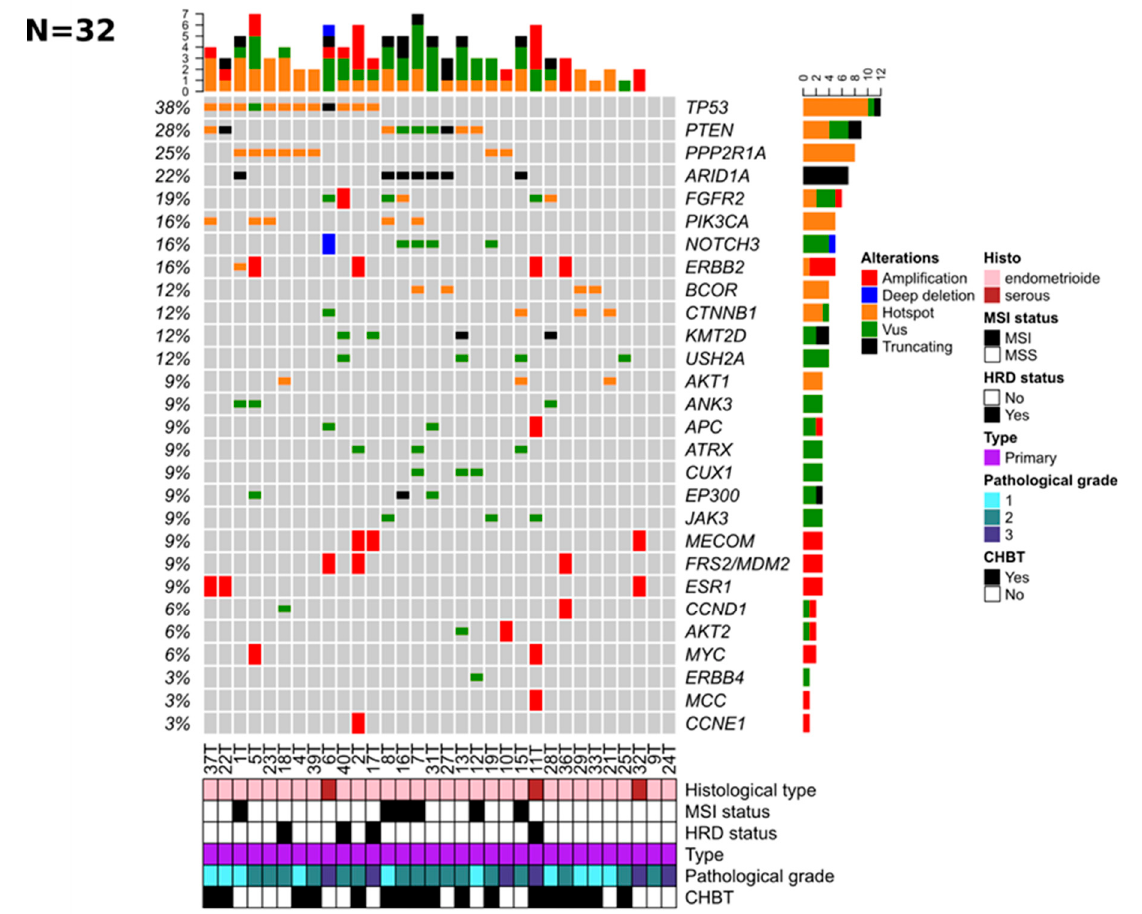
Figure 1. Genomic alterations mainly target oncogenic driver genes in 32 primary ECs. Oncoprints of the 28 frequently altered genes were analyzed in 32 samples: Somatic alterations (mutations or high CNAs (amplification, deep deletion)) are color-coded according to the legend (right part). The genes (rows) are ordered from top to bottom by the decreasing number of altered tumors (right panel), and tumors (columns) are reordered to visualize the mutual exclusivity between samples. The total number of molecular alterations is indicated for each sample (top panel). Among them, a somatic hotspot mutation is defined as a variant with at least 10 occurrences in the COSMIC database [https://cancer.sanger.ac.uk/cosmic, accessed on 30 May 2017] and VUS is a variant of unknown significance. Unique and anonymized patient numbers are indicated. For each sample, the histological type, MSI status, HRD status, pathological grade, and CHBT status are indicated at the bottom of the figure (see corresponding legend on the right